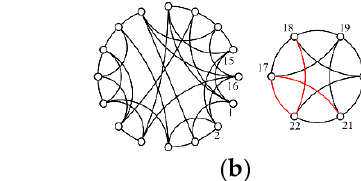
Figure 3. Schematic diagram of repeated edges and disconnection. ( a ) Schematic diagram of repeated edges; ( b ) schematic diagram of disconnection.